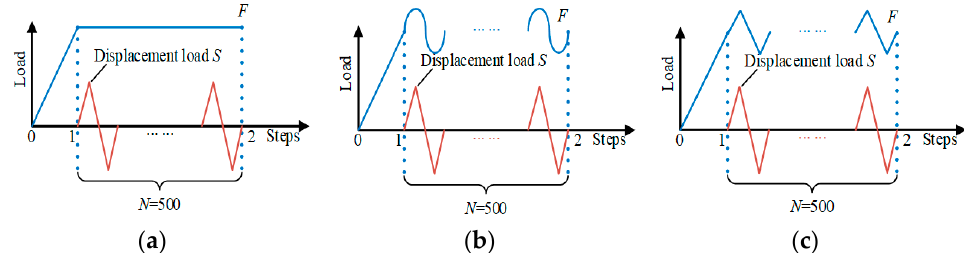
Figure 4. Loading history. ( a ) Constant normal load; ( b ) sine normal load; ( c ) triangular normal